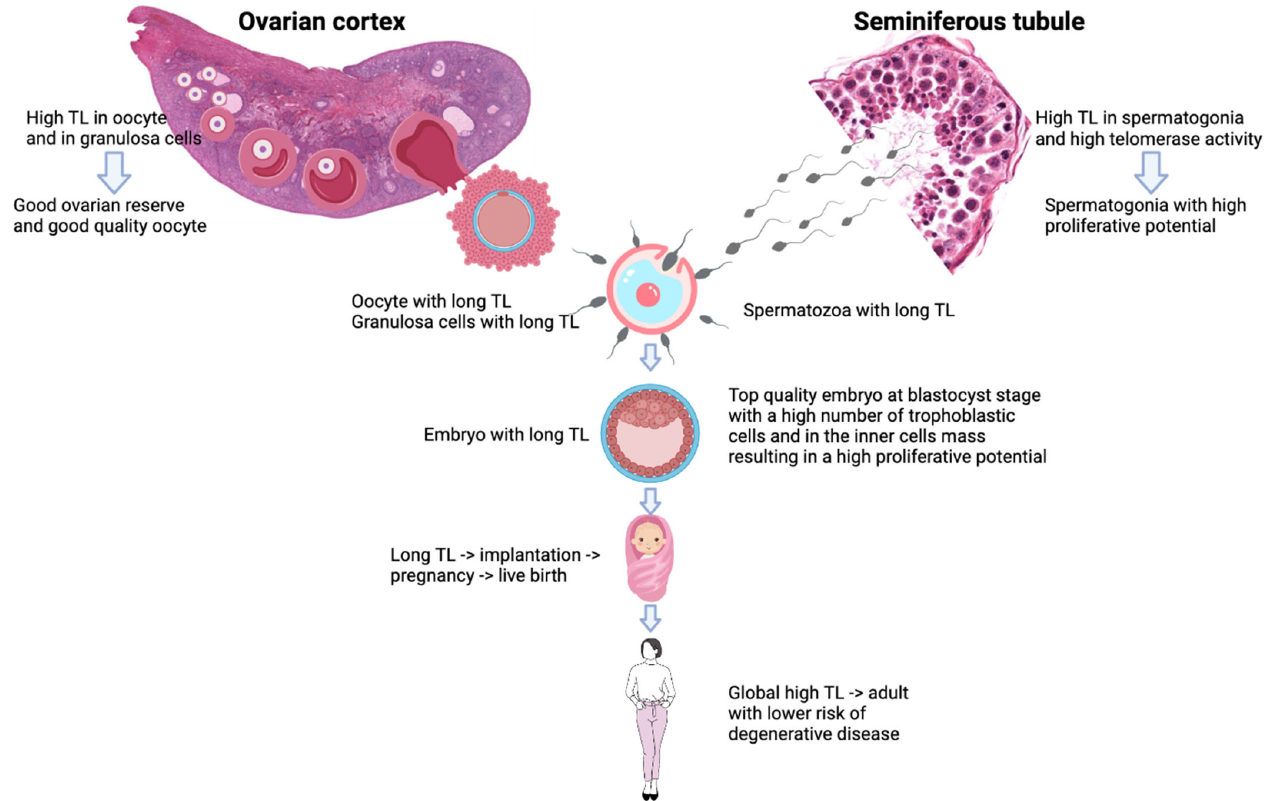
Figure 2. Telomere length inheritance and influences on offspring’s health.